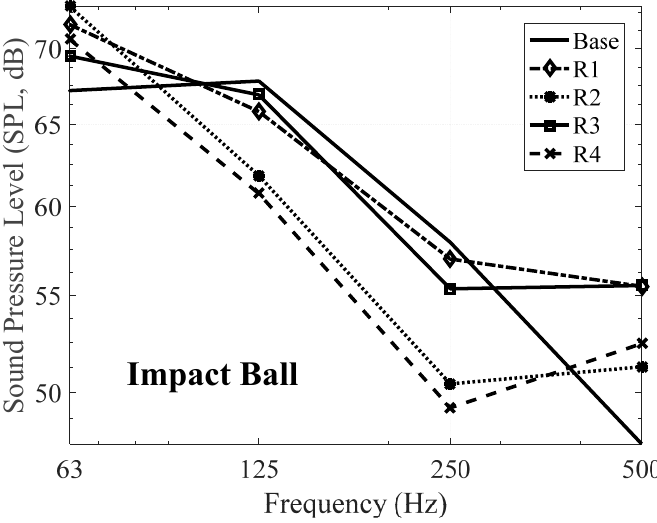
Figure 16. Floor impact sound level with the proposed materials in 1/1 Octave bands—Impact ball.